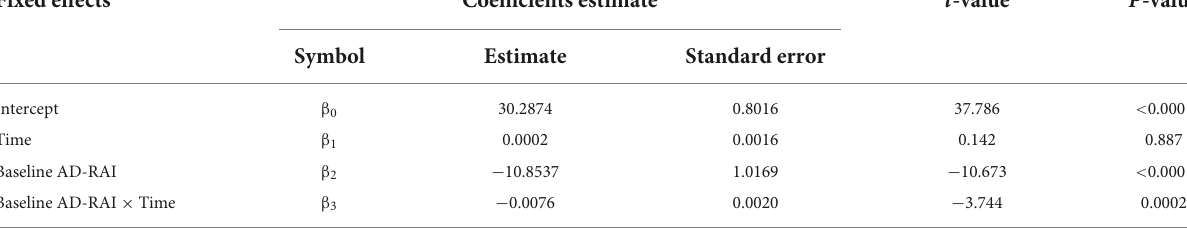
TABLE 6 Estimated coefficients based on LME Model for the MMSE.